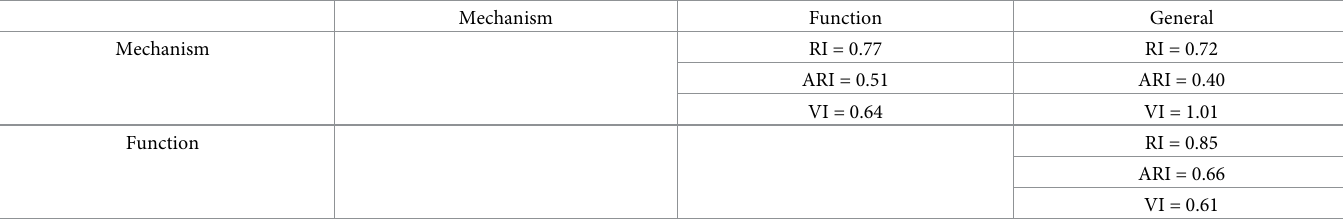
Table 1. Similarities between the mechanism, function, and general item clusterings (higher numbers mean greater similarity for the RI and ARI, while lower num- bers mean greater similarity for the VI). Mechanism Function